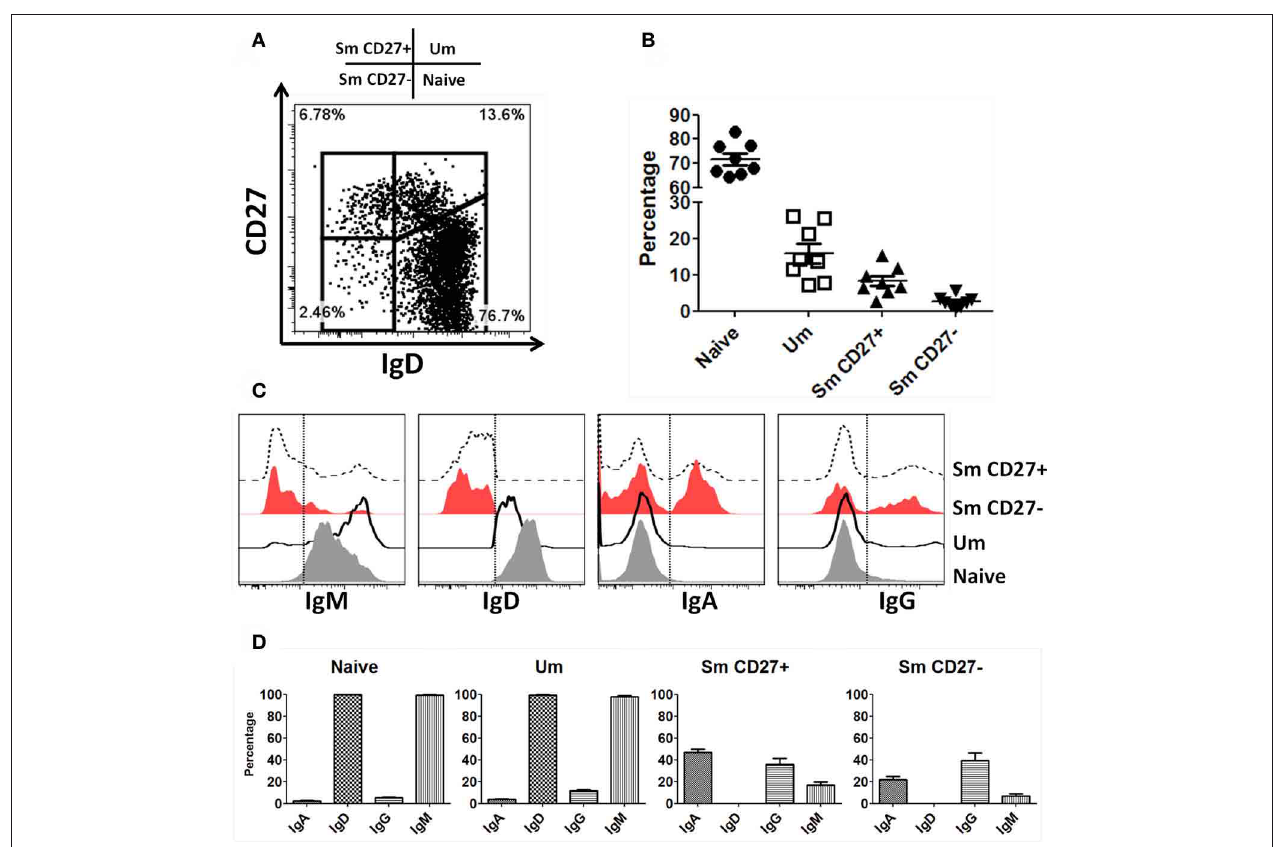
FIGURE 1 | Naïve and B M cell subpopulations defined by IgD and CD27 markers in PBMC. Four B cell (CD19 + CD3 − ) subpopulations are defined by expression of IgD and CD27: Naïve (IgD + CD27 − ), Um (IgD + CD27 + ), Sm CD27 + (IgD − CD27 + ), and Sm CD27 − (IgD − CD27 − ) (A) . The percentages of these B-cell subpopulations showed little variation in 8 healthy adult